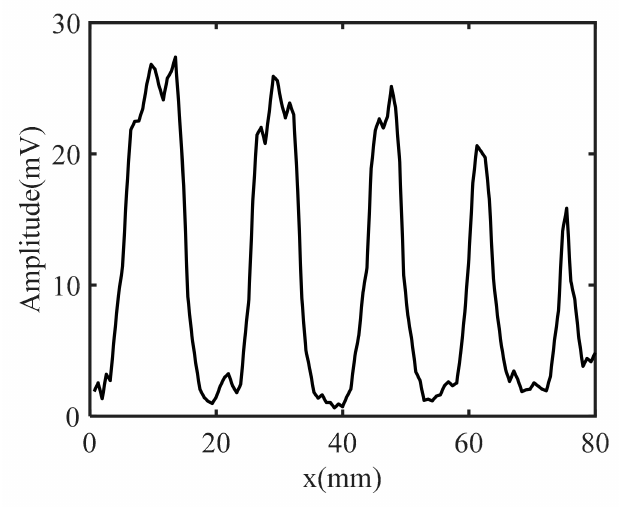
Figure 13. The C-scan image based on reflected transverse waves (2S) from the composite